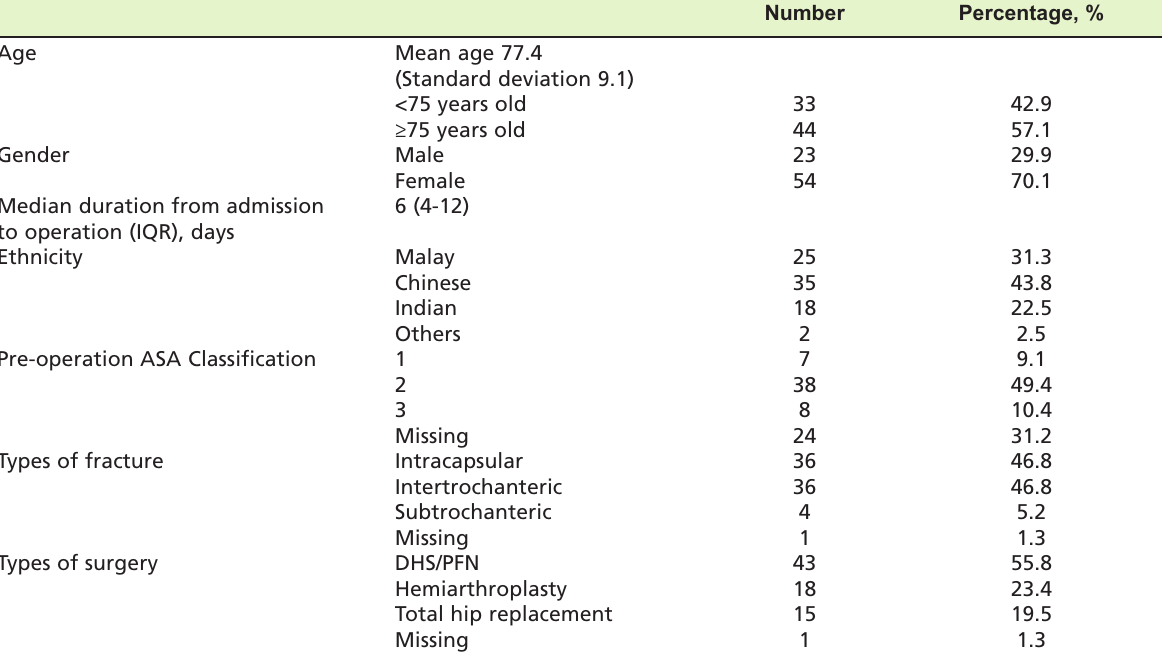
Summary of patient characteristics Table I: